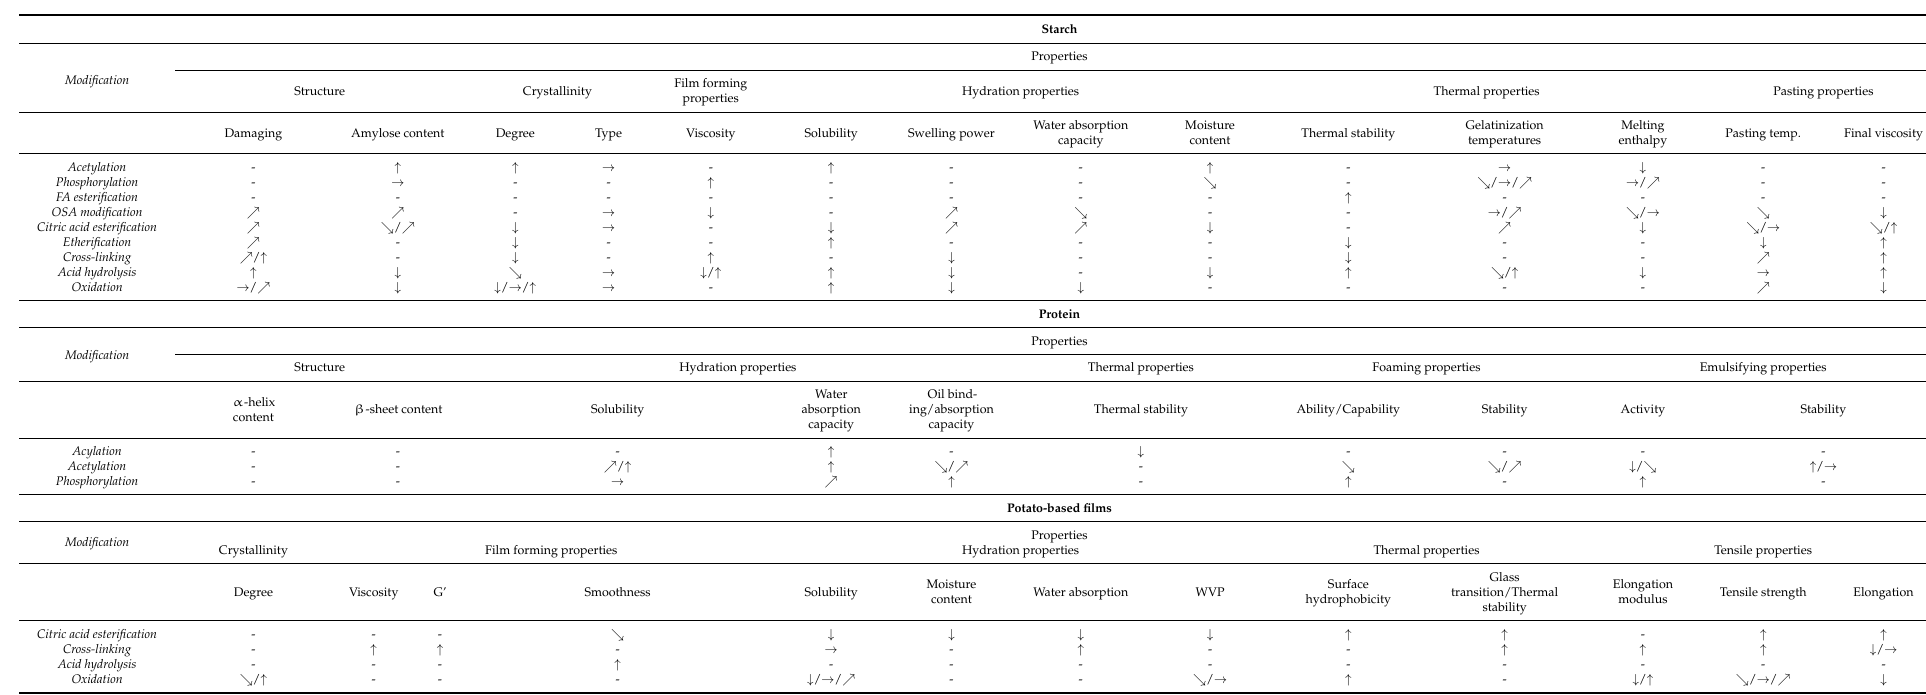
Table 3. General overview of changes induced by different chemical modification methods on potato starch, potato protein and potato-based films structure and properties (specific processing parameters or changes in processing parameters are not considered here, but can be looked up above). Abbreviations and references: Acetylation [158,160], Phosphorylation [155,161], FA (fatty acid) esterification [144], OSA (octenyl succinic anhydride) modification [162–165], Citric acid esterification [146,156,166,167], Etherification [145,169,170], Cross-linking [172–174], Acid hydrolysis [142,166,175,176], Oxidation [147,178,179,181–183], (cid:38) (slight decrease), - (no data